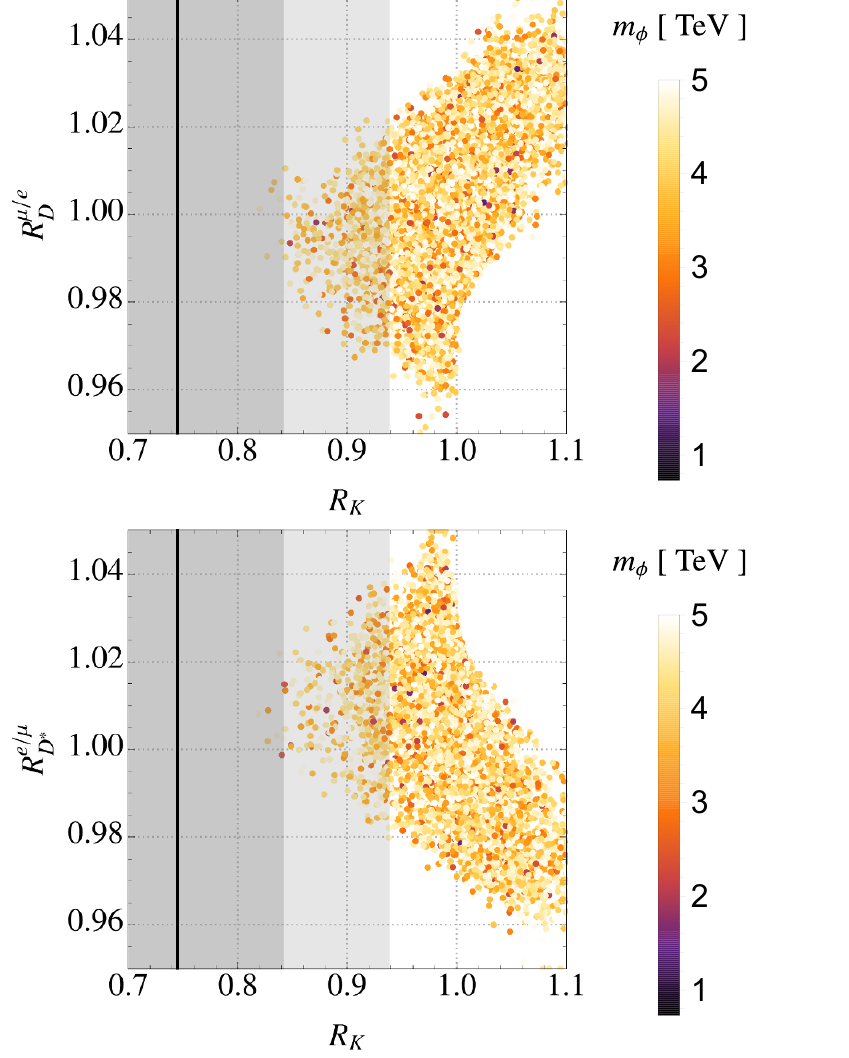
Figure 6. The results of our random scan showing R